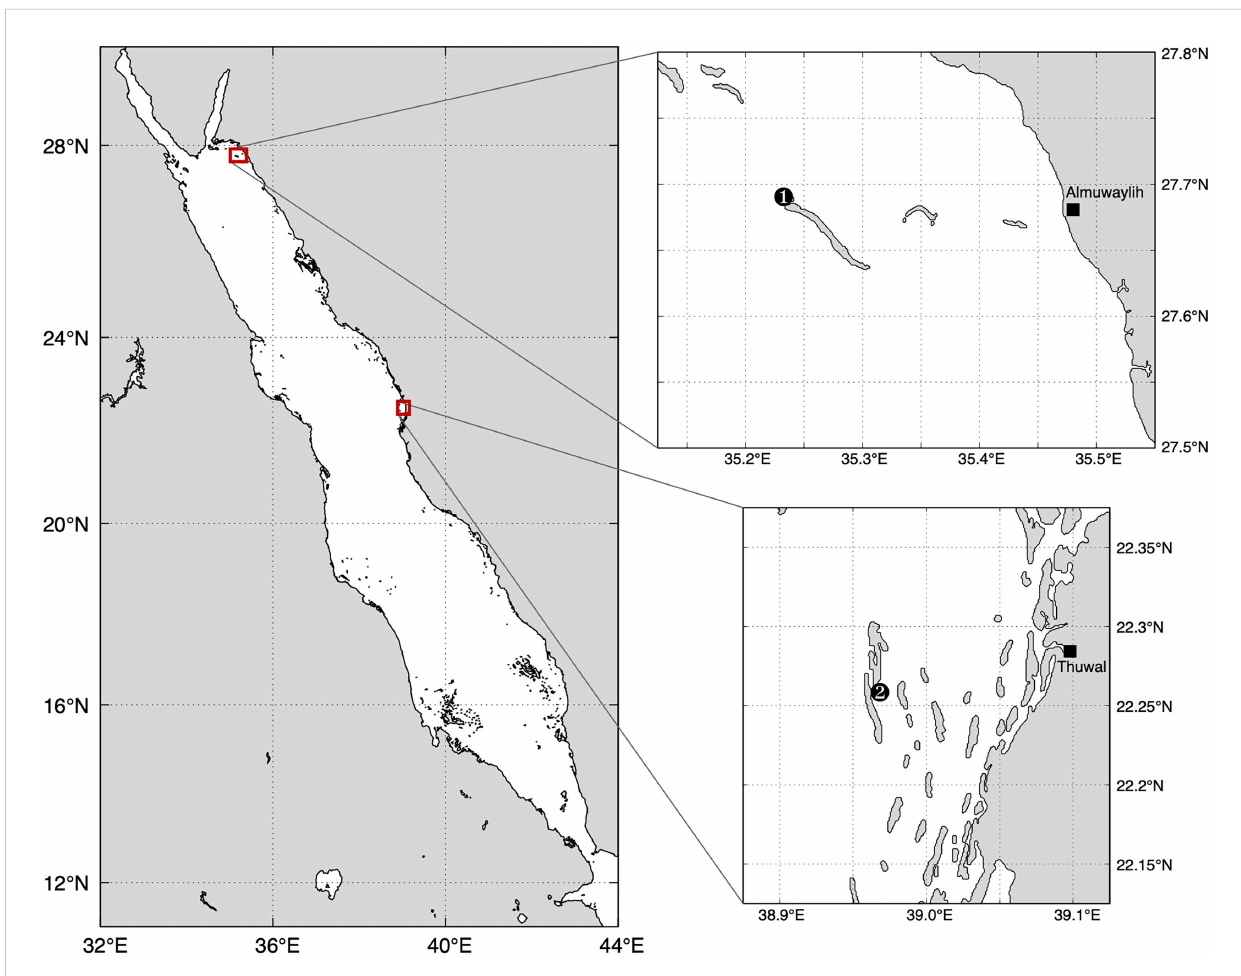
FIGURE 1 Red Sea map indicating the study locations of the Stylophora pistillata experiment (1) in the northern Red Sea, and study site of the Pocillopora verrucosa experiment in the central Red Sea